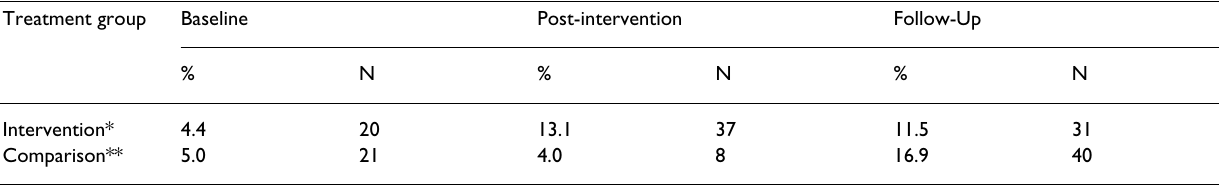
Table 4: Percentage distribution of women who reported receiving assistance in selecting a method Treatment group Baseline Post-intervention